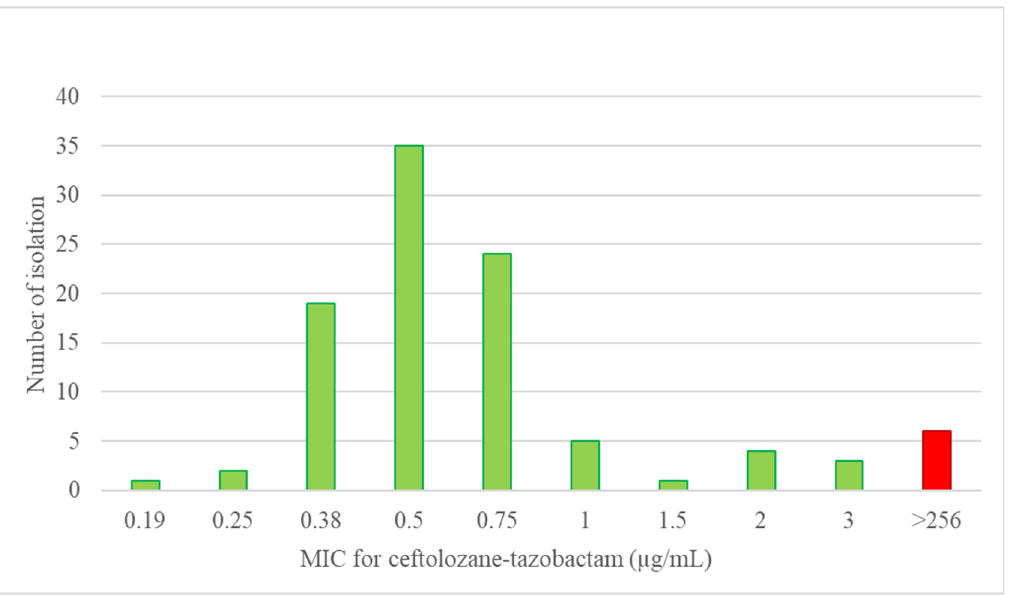
Figure 2. The gradient strip MIC distribution for ceftolozane-tazobactam among the 107 present study PA isolates.